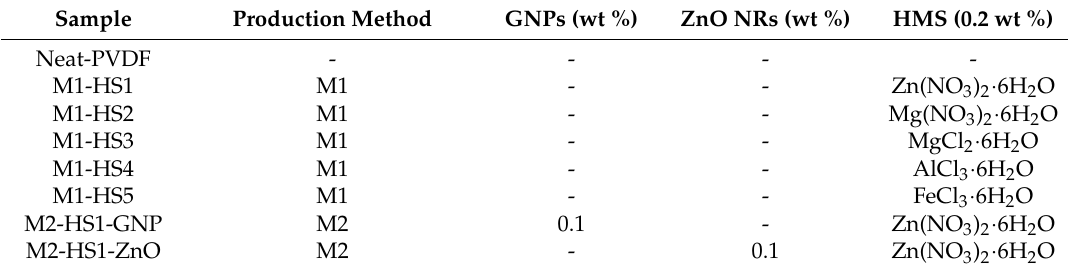
Table 1. List of the produced specimens of PVDF nanocomposite adding graphene nanoplatelets (GNPs), zinc oxide nanoroads (ZnO-NRs) and hexahydrate metallic salt